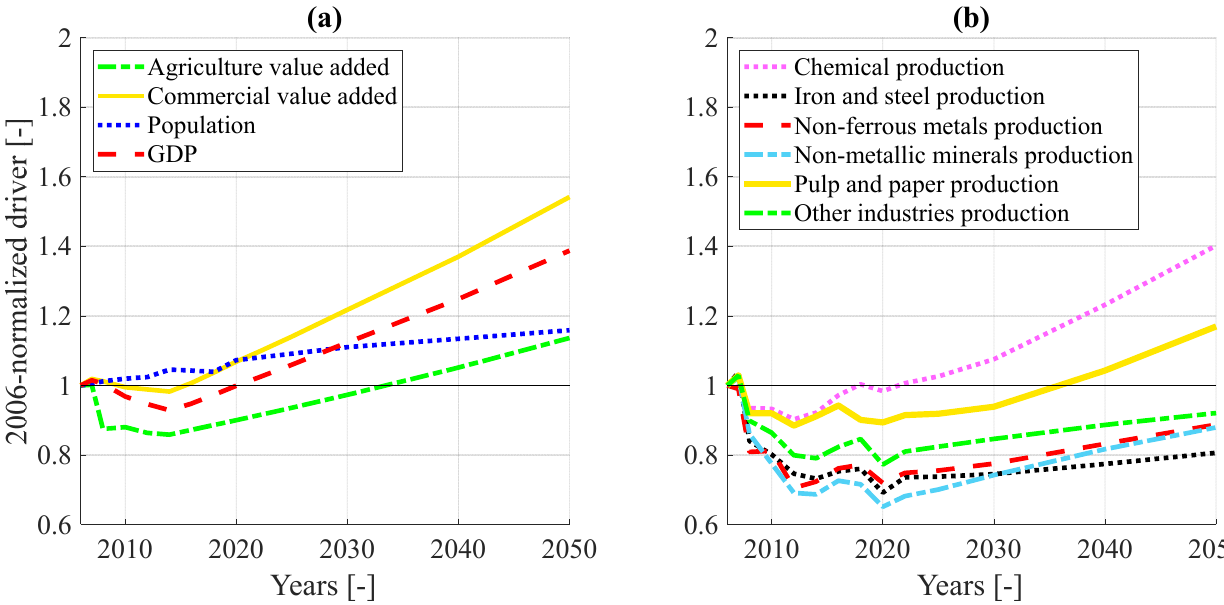
Figure A2. 2006-normalized socio-economic drivers included in TEMOA-Italy: ( a ) agriculture and commercial value added, population and GDP (2006–2018 are historical data, 2020–2050 are future projections from [63]); ( b ) industrial production for each industrial subsector (2006–2020 are historical data, 2022–2050 are future projections from [15]).